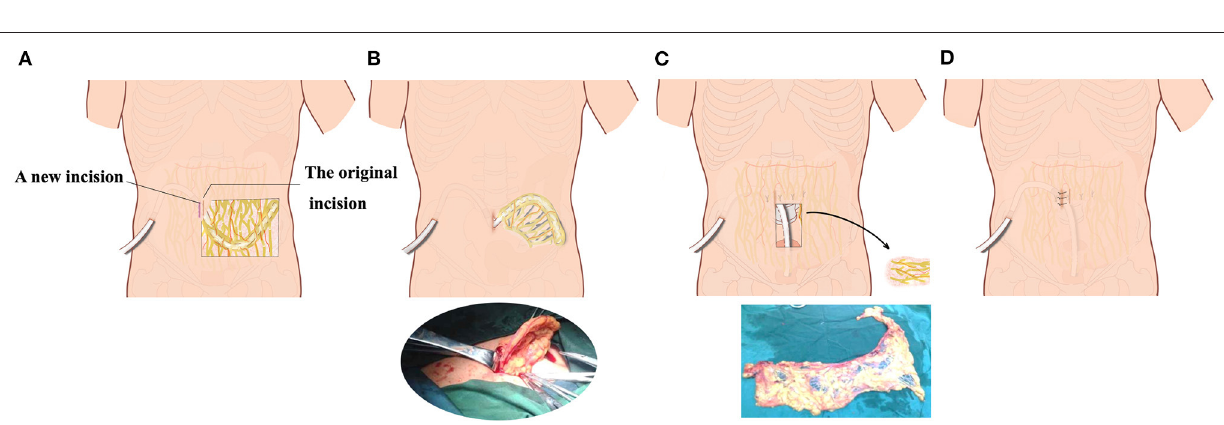
FIGURE 2 | Schematic diagram of the second operation with preservation of peritoneal dialysis catheter and subcutaneous tunnel. (A) A second incision was selected lateral to or medial to the original abdominal incision in the omentum wrapping patient. (B) The internal peritoneal segment of the peritoneal dialysis catheter and part of the omentum were pulled out from the surgical incision. (C) After partial excision of omentum around the catheter, the catheter was re-inserted into the pelvic cavity. (D) The peritoneum, anterior sheath of rectus abdominis, subcutaneous tissue, and skin were sutured layer by